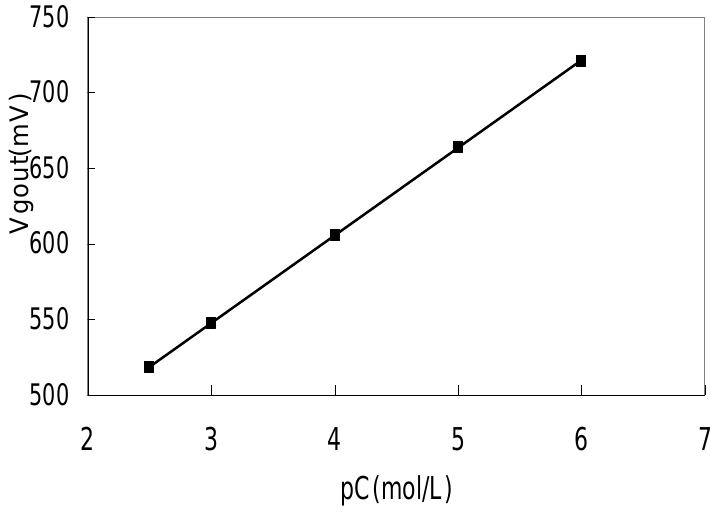
Figure 4. Calibration of